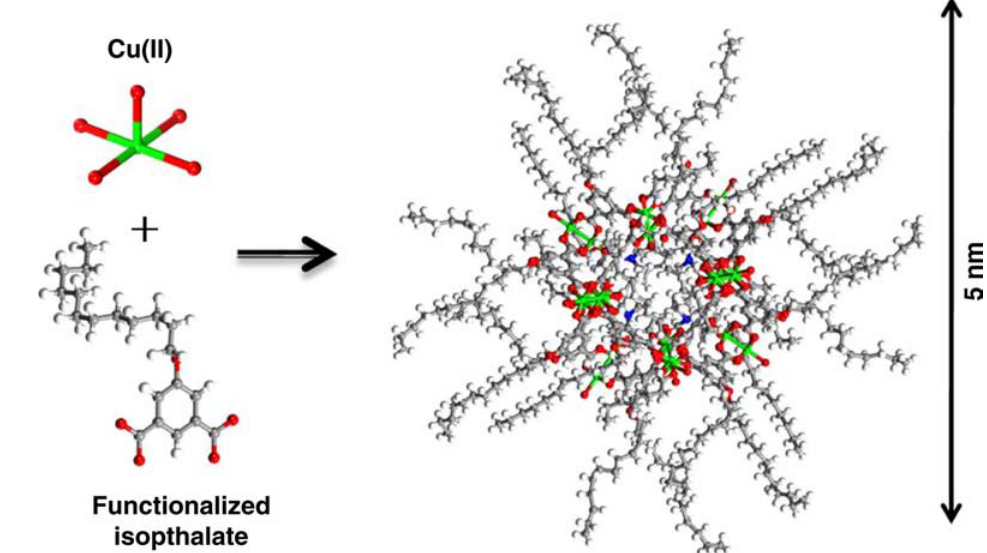
Figure 4. Self-assembled MOP with 24 lipophilic, saturated aliphatic, chains decorating its surface (to the left is crystal structure of the MOP). 5 This MOP with diameter of , 5nm was utilized as synthetic ion channel when situated in-between a lipid bi-layer membrane. 8